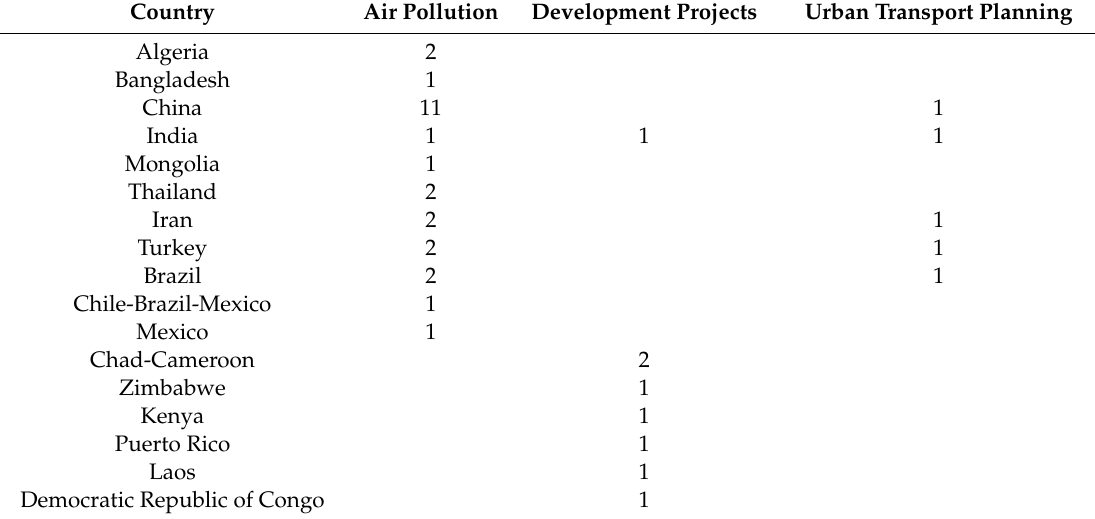
Table 4. Number of studies by leading topic and by